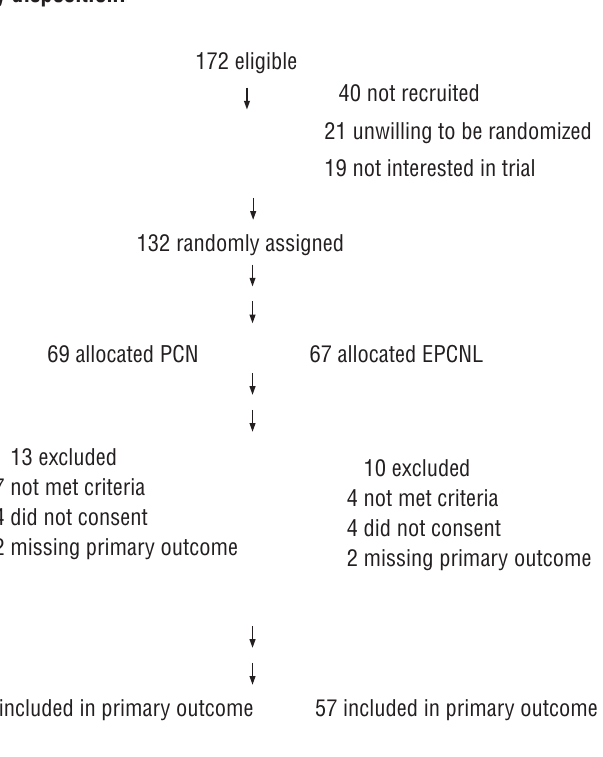
Numbers of participants declining further follow-up or not responding are cumulative in direction of participant